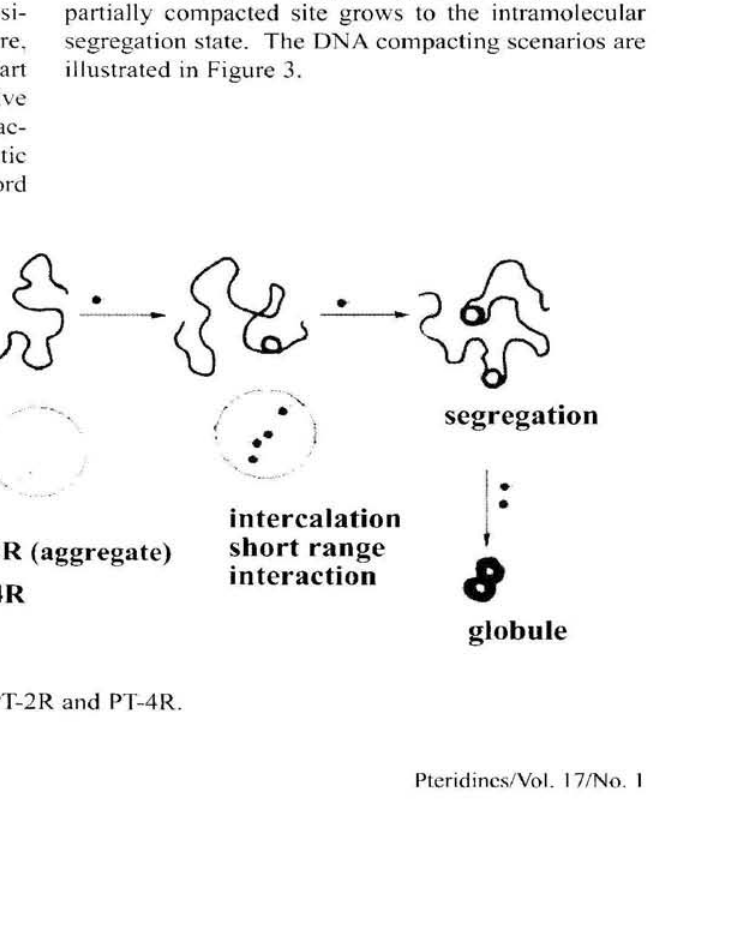
Pteridincs/Vol. 1 7/No.